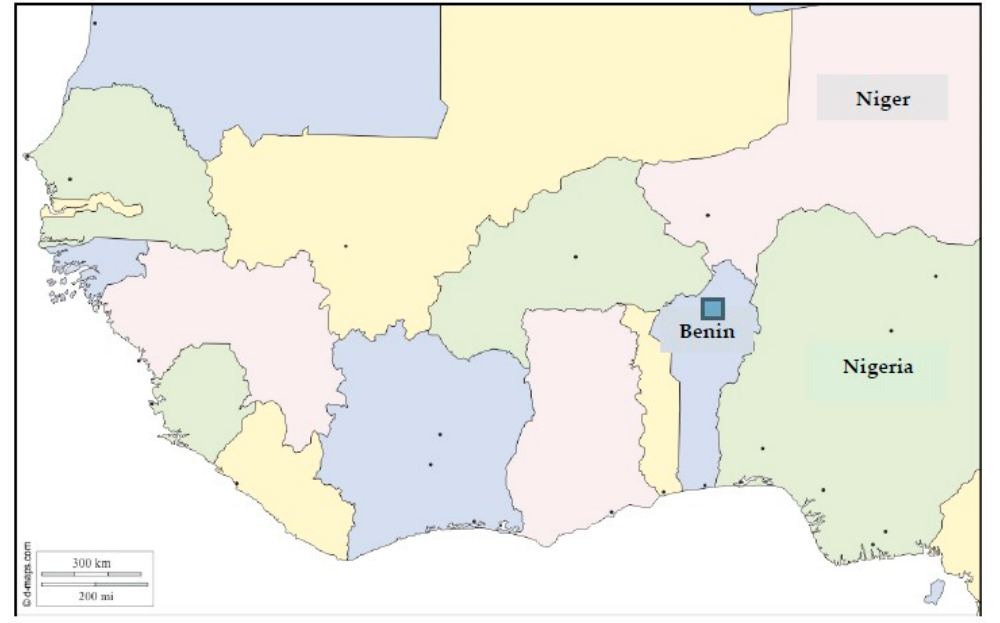
Figure 2. Map of West Africa showing study areas.